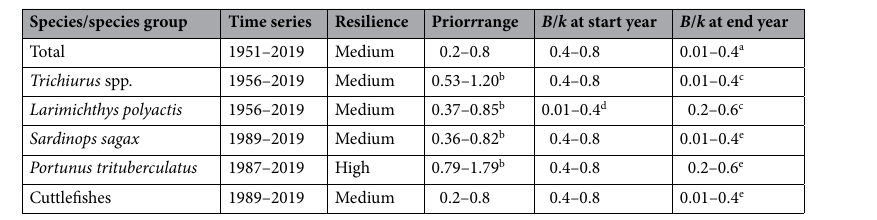
Table 2. The prior range for r and B / k and other information of the selected species or species groups in China. a Referred from Zhang et al . 20 ; b referred from Fishbase (www. fishb ase. org); c referred from Zhai and Pauly 21 ; d referred from Zhuang 22 ; e referred from Martell and Froese 23 .